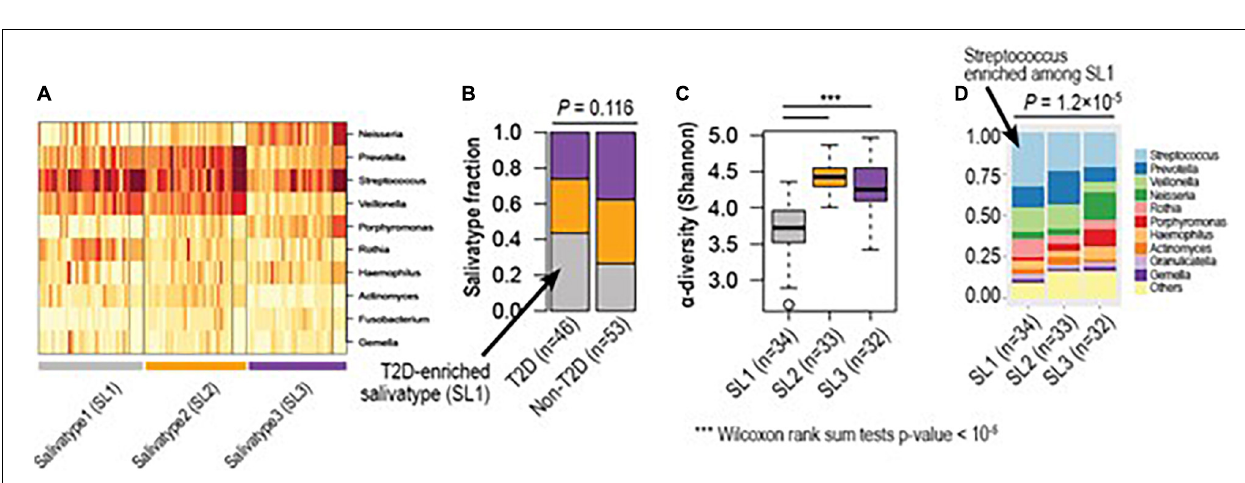
FIGURE 3 | Hidden microbial community structure (salivatype) among diabetic and non-diabetic groups. (A) Based on unsupervised clustering, we identified three clusters of different microbial compositions, named salivatype 1, 2, and 3. Salivatype 1 was enriched in Streptococcus , salivatype 2 enriched in Prevotella, and salivatype-3 enriched in Neisseria . (B) Salivatype-1 was enriched among diabetic subjects compared to non-diabetic subjects (Chi-square tests p -value = 0.116). (C) Salivatype-1 was the lowest in alpha diversity (*** Wilcoxon rank sum tests p -values < 1e-5). (D) The top-10 most abundant genera of different